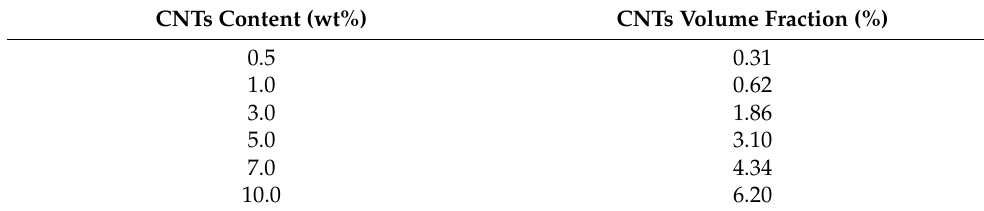
Table 6. CNTs volume fraction of varied